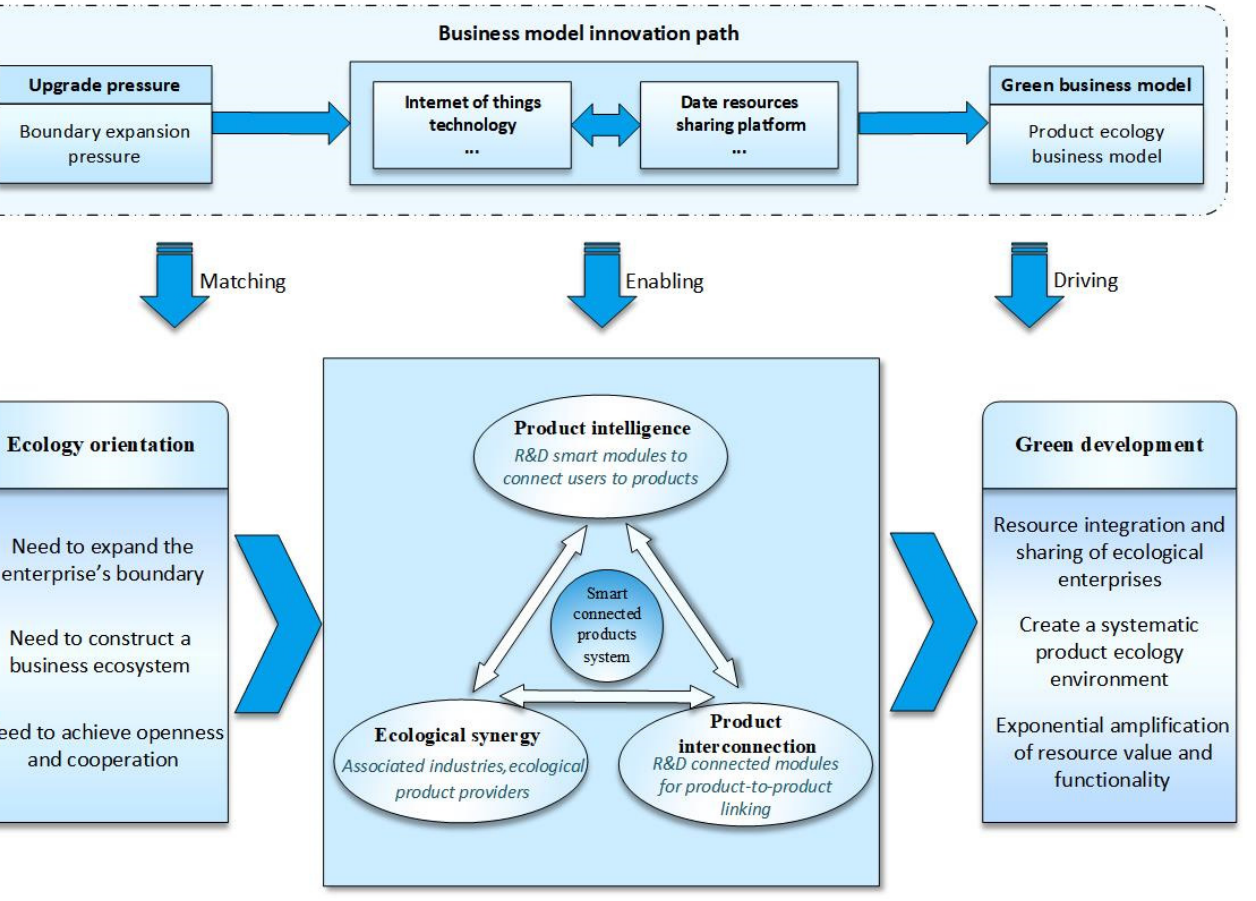
Figure 7. Conceptual model of the ecology-oriented path.